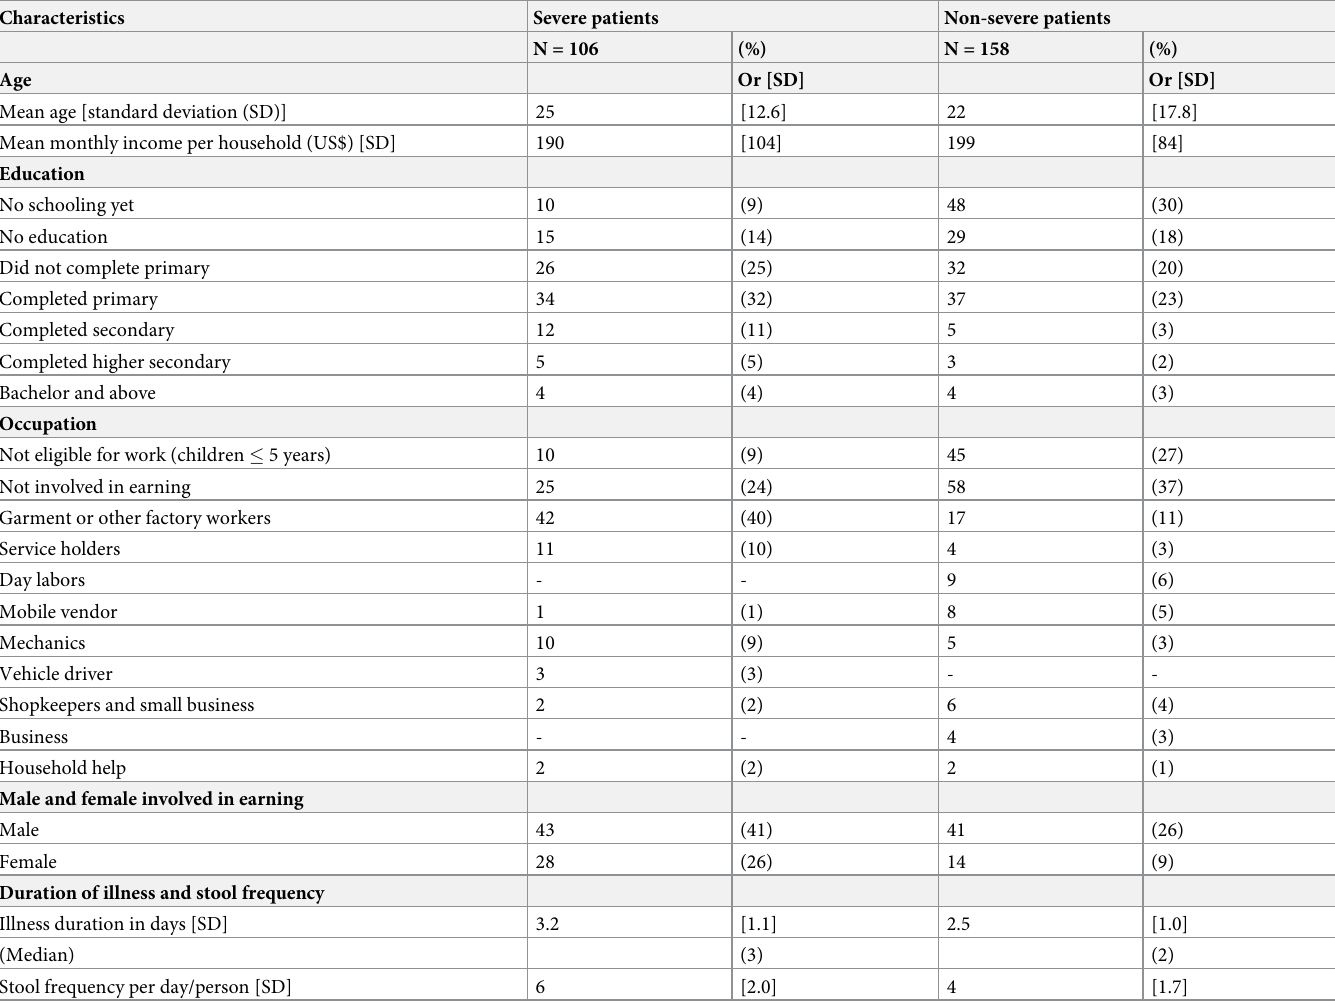
Table 1. Education and occupation of the severe and non-severe diarrhea patients of Tongi Township in Dhaka, Bangladesh from September 2015 to June 2016.